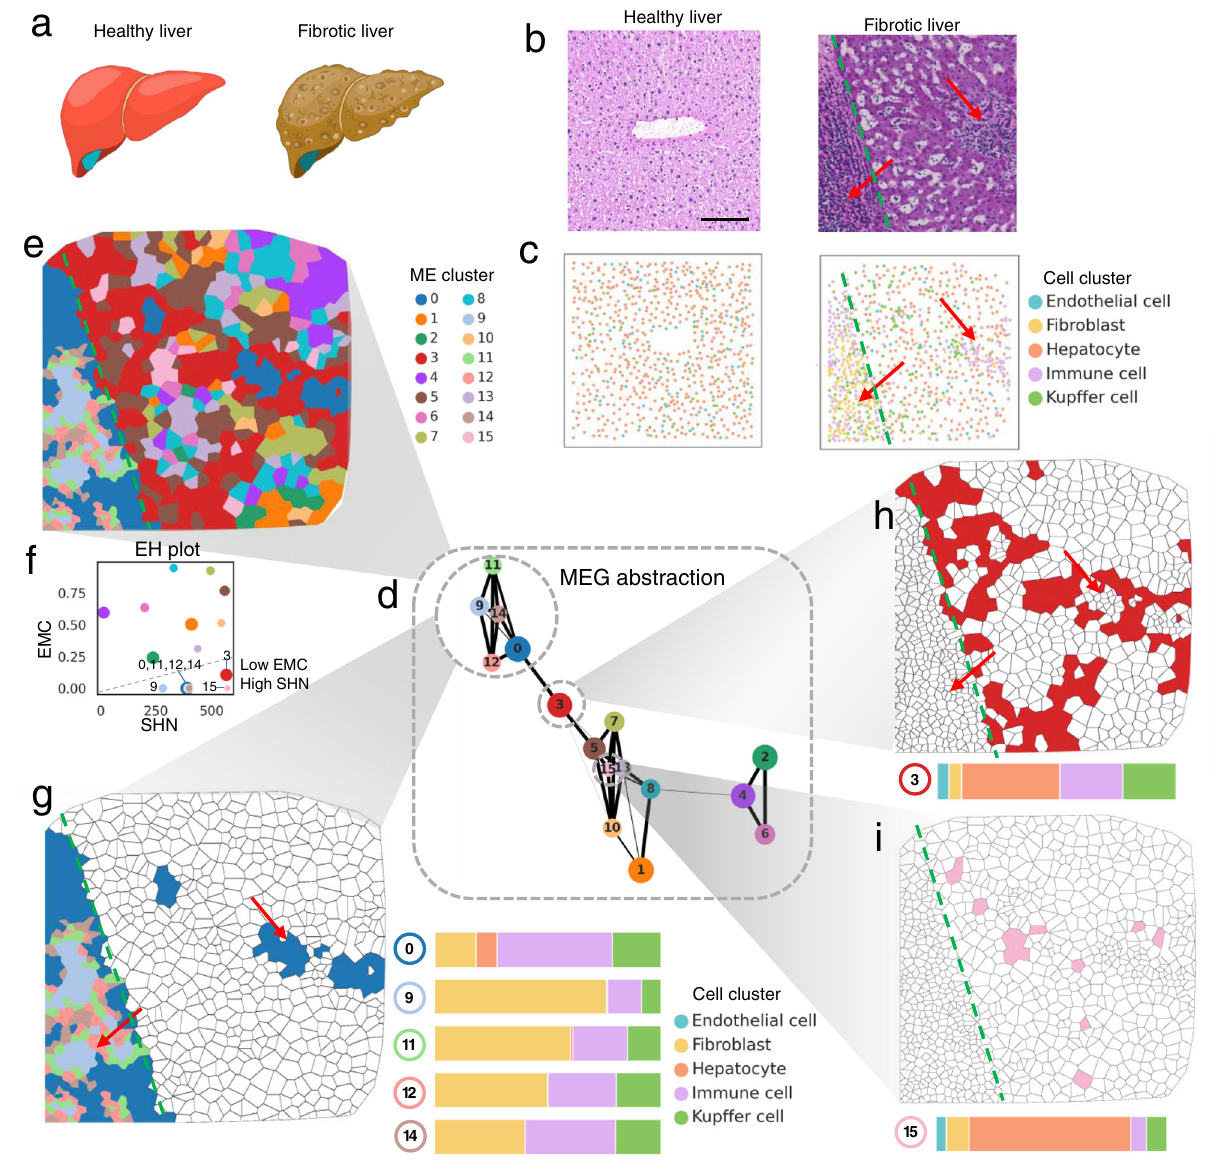
Fig. 6 | SOTIP recovers differential microenvironments between liver samples. a Illustration of healthy and fi brotic livers. b Histological images of the healthy (left) and fi brotic (right) liver samples. The red arrows indicate fi brotic niche. The green dashed line indicates the fi brotic boundary. Scale bar: 100 μ m. with Fig. 6b. The red arrows and green dashed line are consistent with those in Fig. 6b. d MEG abstraction. Each node is a cluster of densely connected